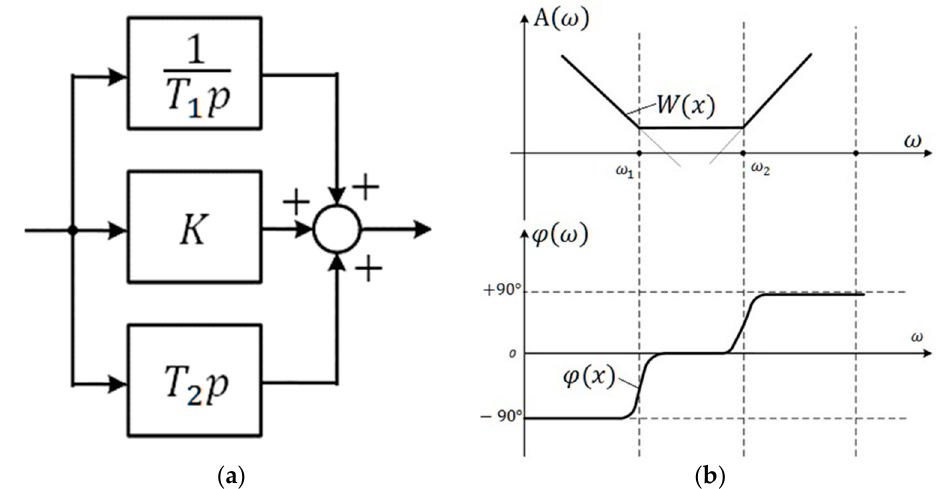
Figure 6. PID controller circuit ( a ) and its logarithmic frequency characteristic ( b